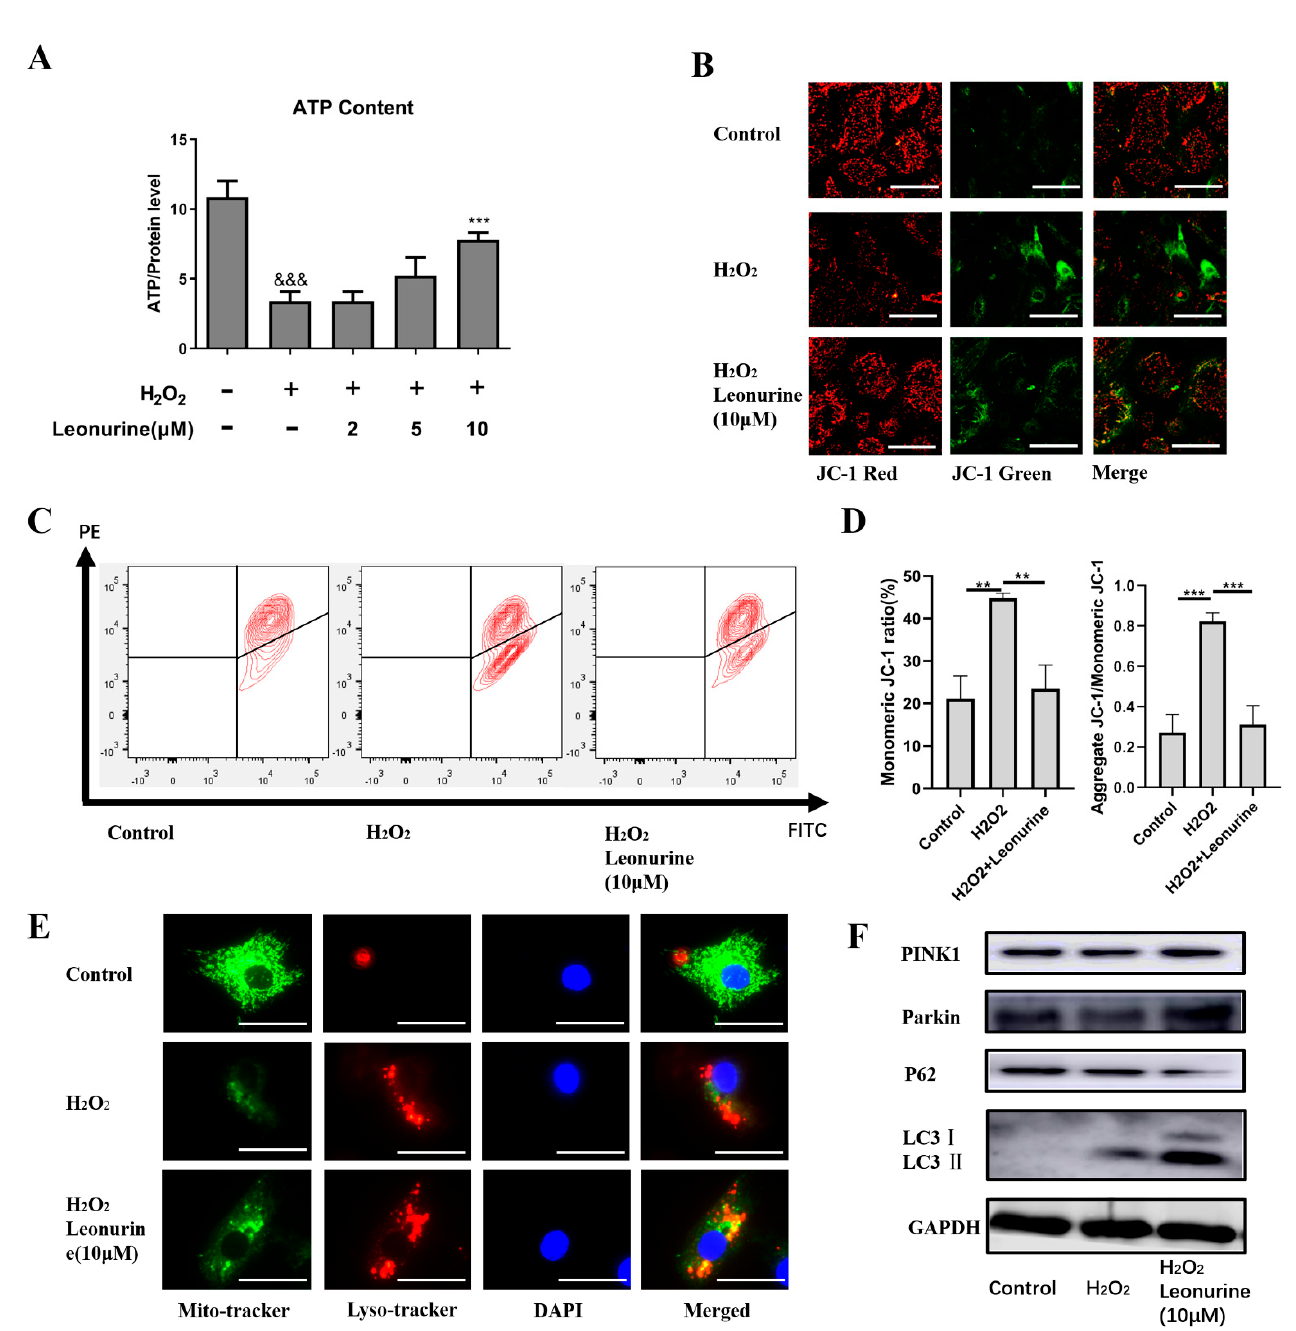
Figure 4. Leonurine activate mitophagy during ROS damage. ( A ) Intracellular ATP level ( B ) Measurement of mitochondrial membrane potential by microscopy (scale bar = 100 μ M). ( C ) Measurement of mitochondrial membrane potential by flow cytometry. ( D ) Quantitative analysis of flow cytometry results. ( E ) Mitochondrial and lysosome colocalization analysis (scale bar = 50 μ M). ( F ) Expression level of mitophagy-related proteins. (&&& p < 0.001 vs. control group. ** p < 0.01, *** p < 0.001 vs. H2O2 group).